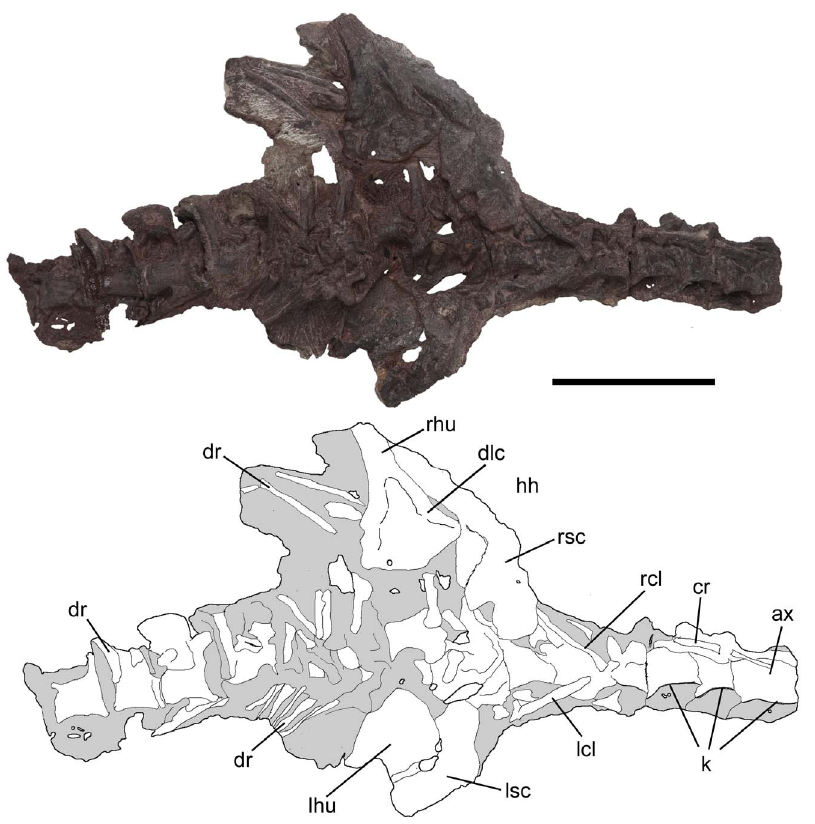
Figure 6. Cervical and dorsal vertebrae, and scapulacoracoids of Pseudochampsa ischigualastensis (PVSJ 567) in ventral view. Abbreviations: ax, axis; cr, cervical ribs; dlc, deltopectoral crest; dr, dorsal ribs; hh, humeral head; k, ventral keel; lcl, left clavicle; lhu, left humerus; lsc, left scapulacoracoid; rcl, right clavicle; rhu, right humerus; rsc, right scapulacoracoid. Scale bar equals 5 cm.